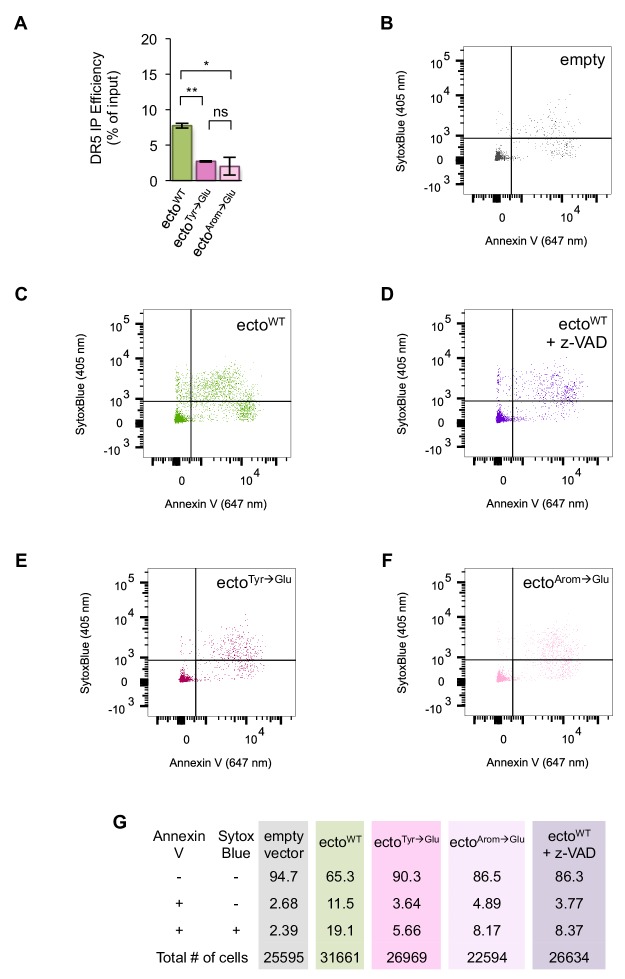
MPZ-ecto peptide engagement of DR5 in cells drives apoptotic cell death.(A) Quantification of the percent of total DR5 recovered in the IPs of GFP-tagged MPZ-ecto peptides, shown in Figure 4G. (n = 2 biological replicates. * denotes p=0.047, ** denotes p=0.0054, and ns indicates p=0.62 from unpaired t-test with equal SD.) The DR5 signal of the input and IP lanes were quantified from the same exposure and then normalized to the amount loaded on the gel. Source data of blots and quantification are provided in Figure 4—source data 1. (B) Flow cytometry measurements of SytoxBlue (405 nm) and annexin V (647 nm) staining of HCT116 transfected with empty vector for 24 hr. (C) Flow cytometry measurements of SytoxBlue (405 nm) and annexin V (647 nm) staining of HCT116 transfected with GFP-tagged MPZ-ecto peptide for 24 hr. (D) Flow cytometry measurements of SytoxBlue (405 nm) and annexin V (647 nm) staining of HCT116 transfected with GFP-tagged MPZ-ecto peptide and co-treated with 20 μm of z-VAD for 24 hr. (E) Flow cytometry measurements of SytoxBlue (405 nm) and annexin V (647 nm) staining of HCT116 transfected with GFP-tagged MPZ-ecto Tyr→Glu peptide for 24 hr. (F) Flow cytometry measurements of SytoxBlue (405 nm) and annexin V (647 nm) staining of HCT116 transfected with GFP-tagged MPZ-ecto Arom→Glu peptide for 24 hr. (G) Table summarizing percent of cells stained in each quadrant of plots shown in B-F.